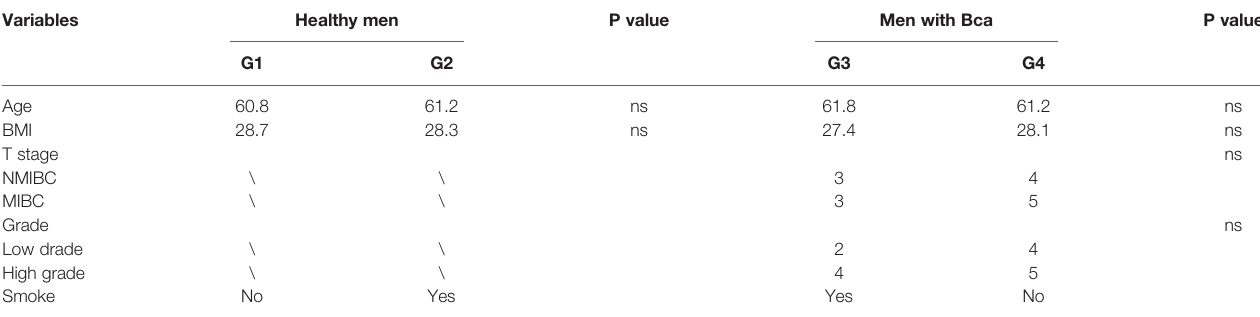
TABLE 1 | Clinicopathological characteristics of the samples. Variables